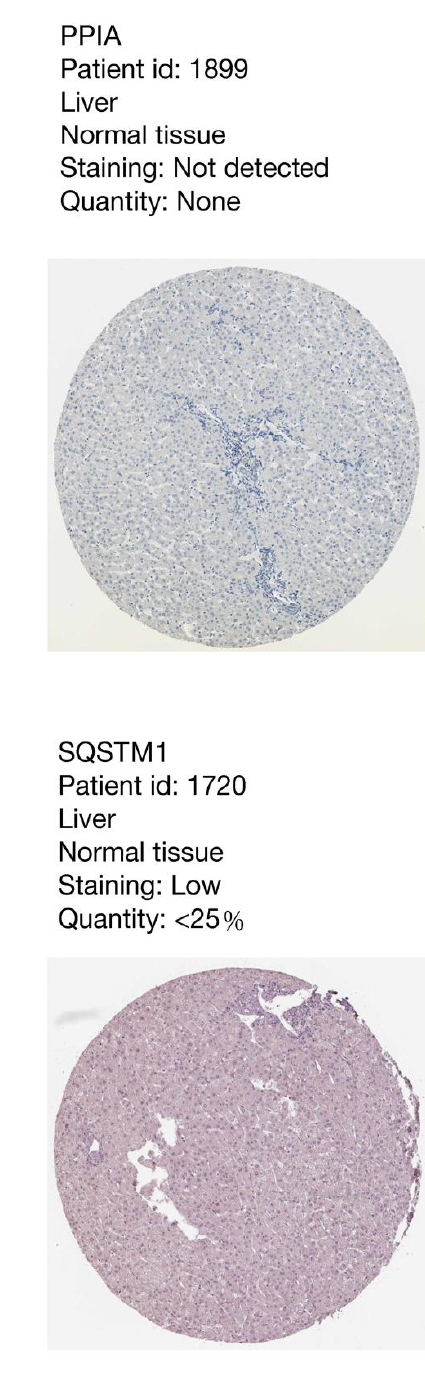
Figure 4. The immunohistochemistry results of PPIA and SQSTM1 from the Human Protein Atlas showed higher expression levels of PPIA and SQSTM1 in HCC tissues than in normal tissues.